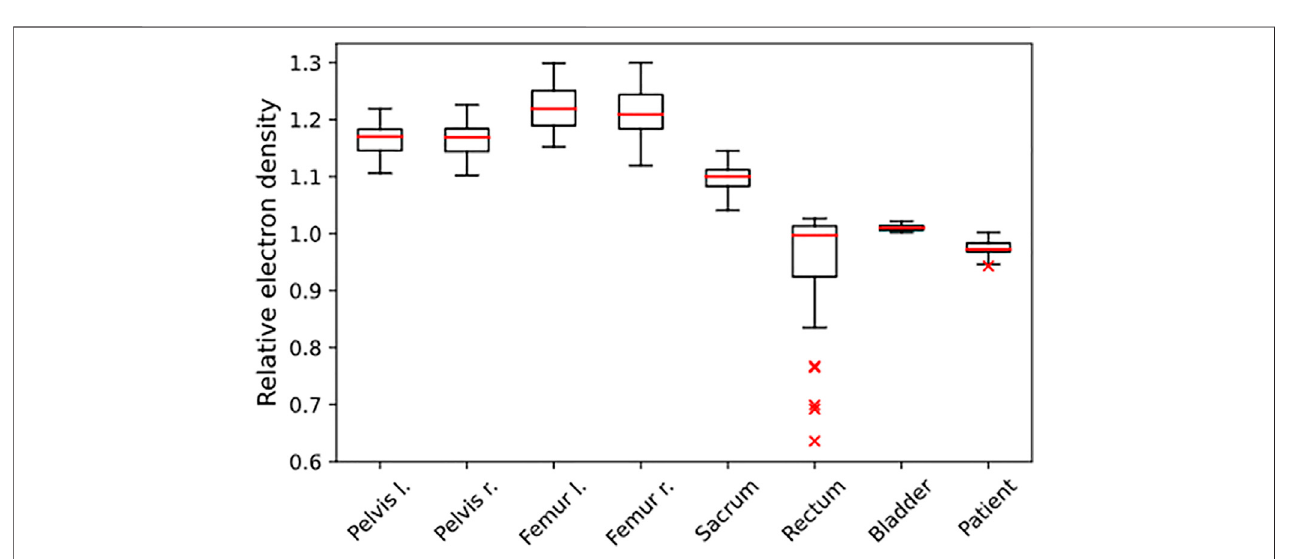
FIGURE1| DistributionofREDs,determinedfromtheindependentpopulationof n =50patients.TheREDsarenormalizedtowater,andthegivenstructureswere used for RED assignment in the PBCT approach.